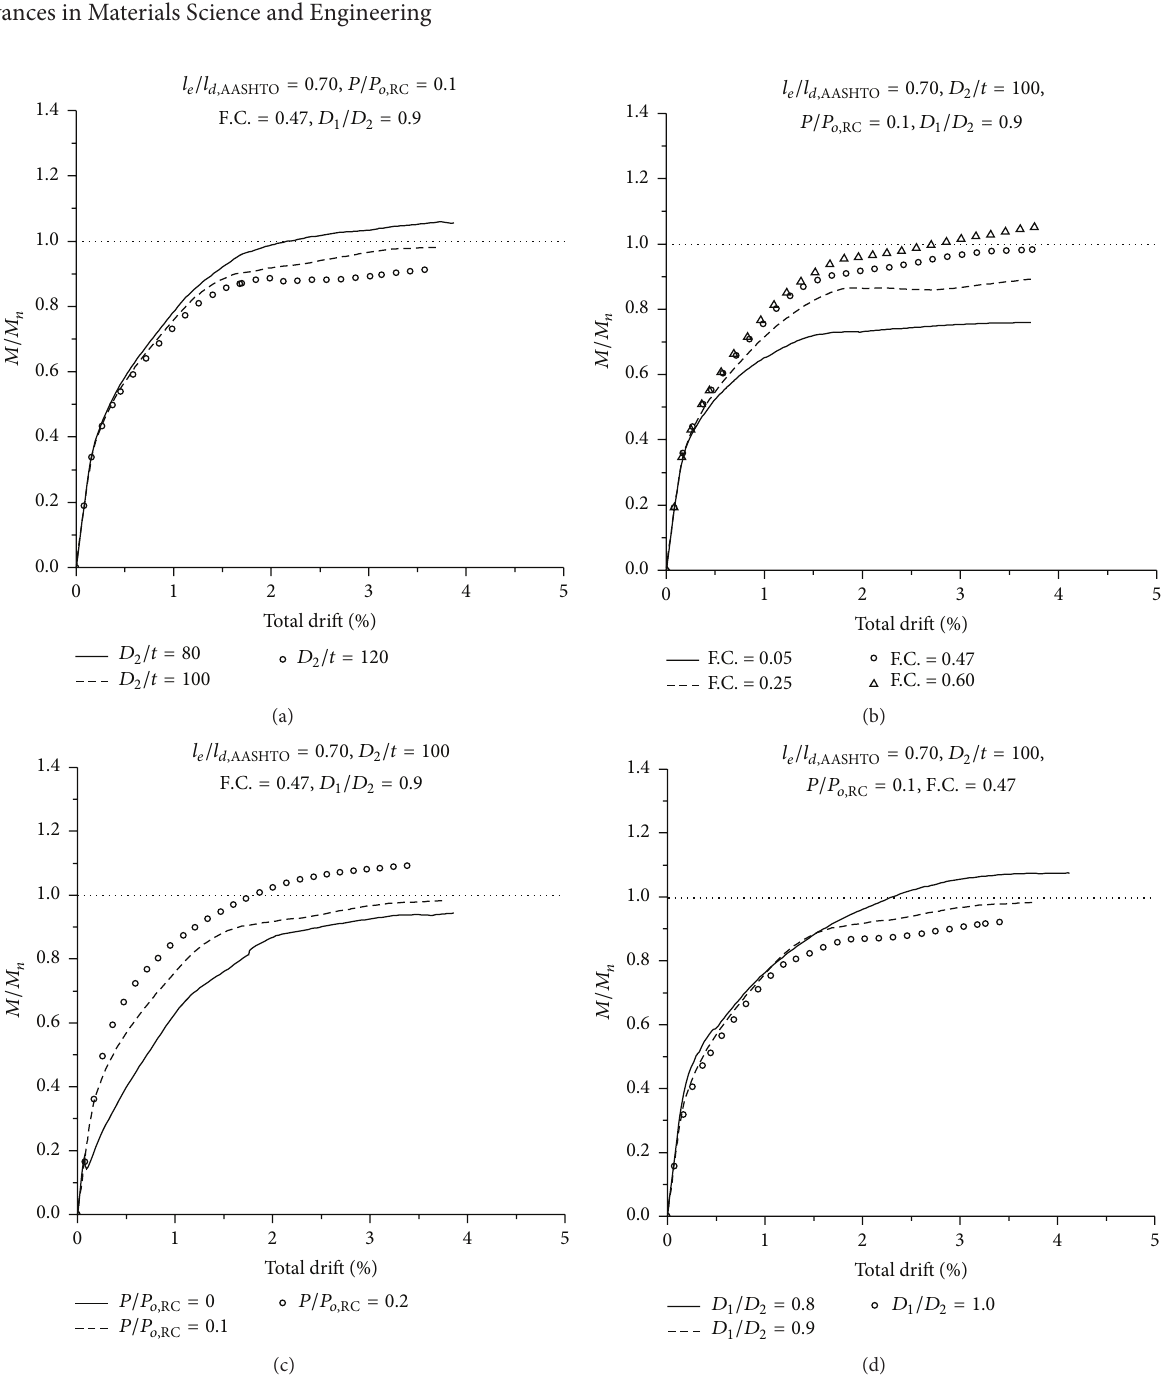
Figure 11: Impact of parameters for 𝑙 𝑒 /𝑙 𝑑, AASHTO = 0.70 : (a) effect of 𝐷 2 /𝑡 ratio; (b) effect of friction coefficient; (c) effect of axial load ratio; and (d) effect of 𝐷 1 /𝐷 2